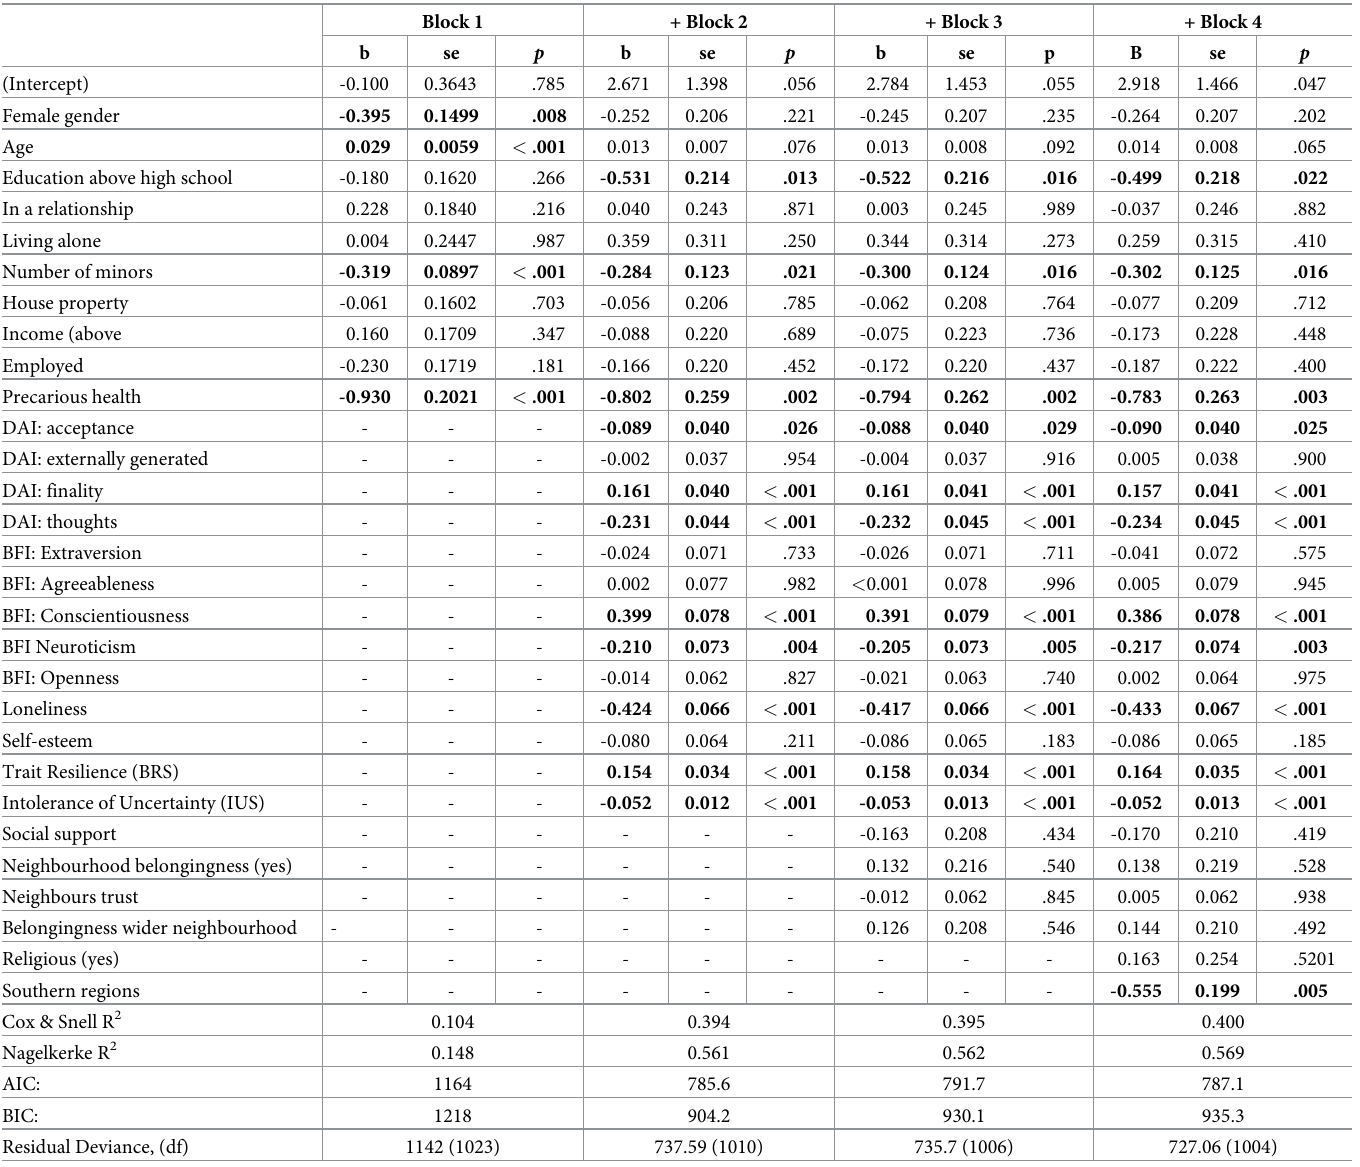
Table 4. Regression